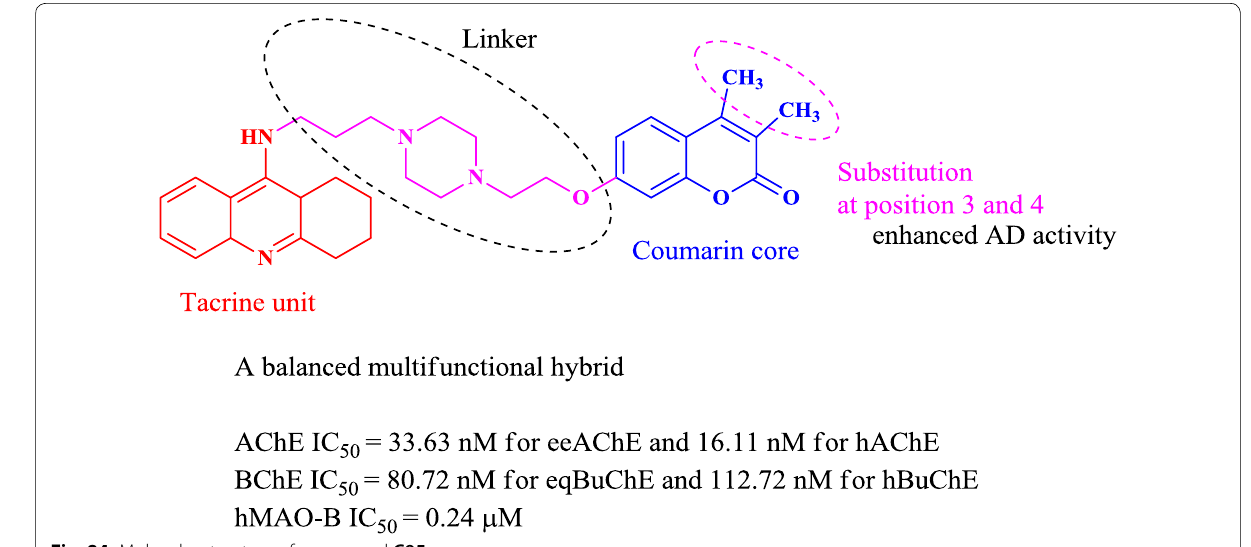
Fig. 84 Molecular structure of compound